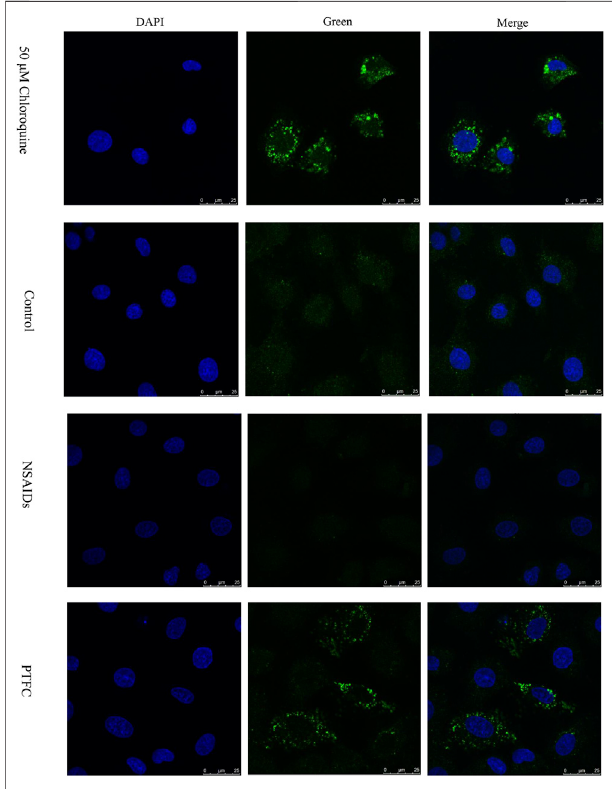
FIGURE 6 | Effect of PTFC on the formation of autophagosome in IEC-6 cells. Immuno fl uorescence staining of LC3-II (Green) was performed. Nuclei were stained with DAPI. Chloroquine (50 μ M) was used as positive control. The results revealed that the LC3-II signal in the diclofenac-treated model group (NSAIDs) was signi fi cantly decreased compared with that in the untreated group (Control), but the positive signal in the PTFC treatment group (PTFC) was signi fi cantly